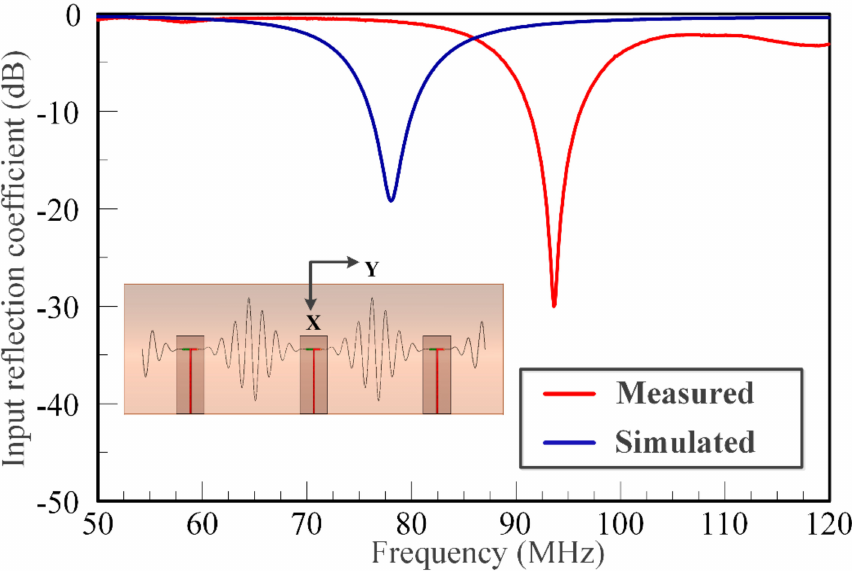
Figure 13. Measured and simulated results of multi-element SEVA-CLA operated as a single antenna